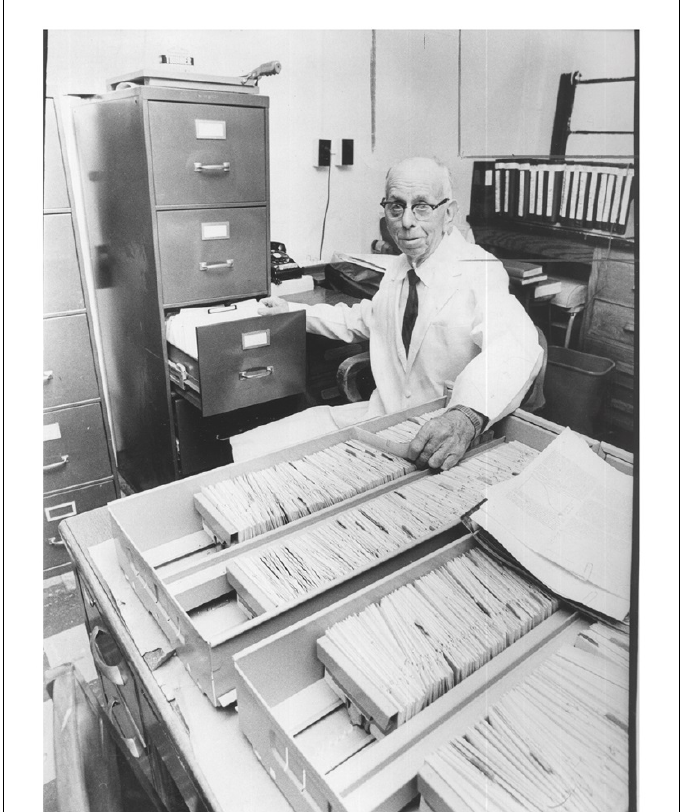
Figure 1 Lemuel Whitley Diggs with his sickle cell